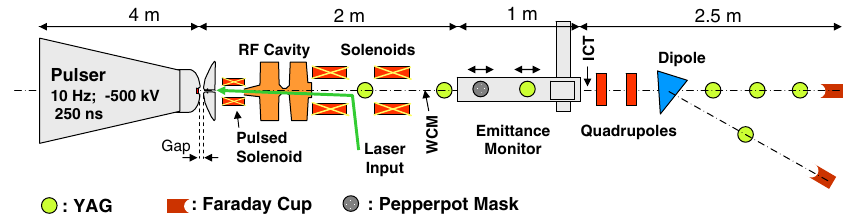
FIG. 3. Schematic of the diode-rf gun and diagnostic beam line.